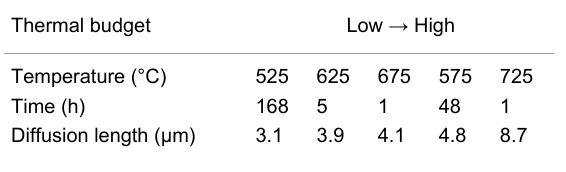
Table 2: Thermal annealing conditions (temperature and time), and corresponding thermal budgets.